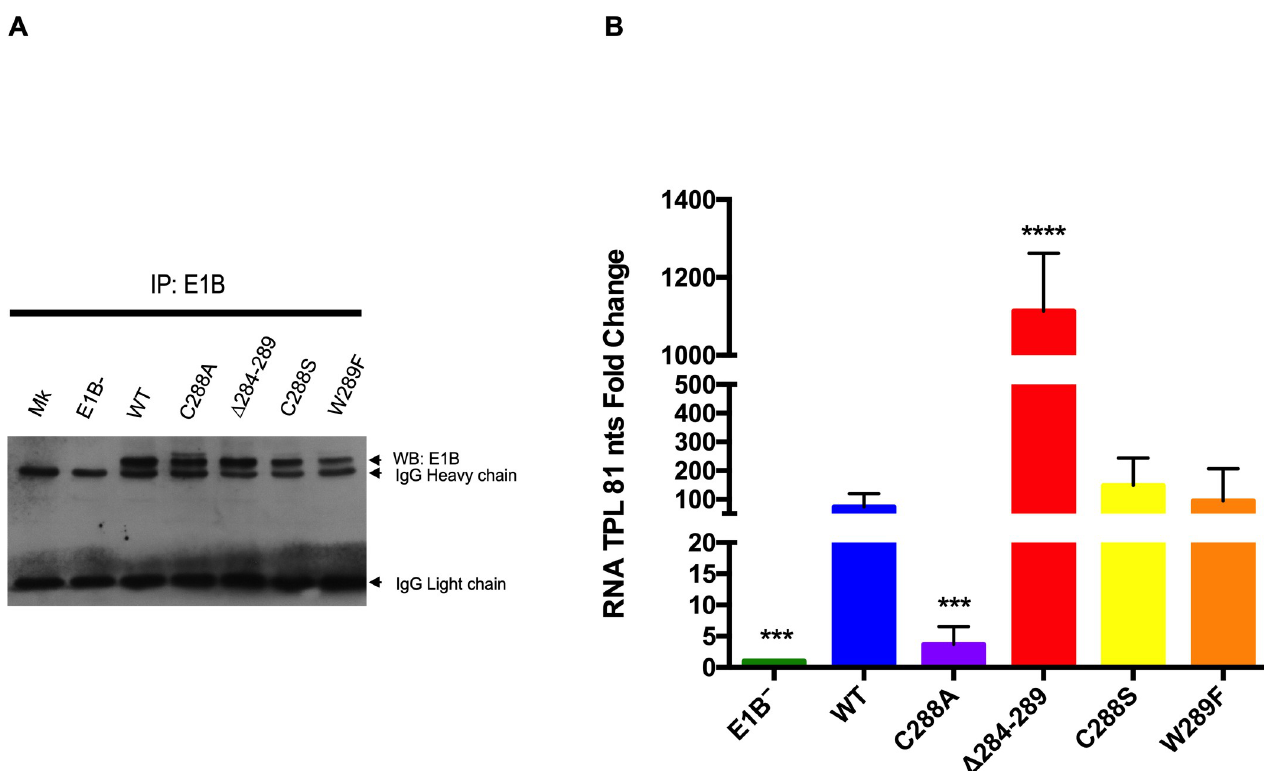
Fig 1. E1B 55K interacts with RNA in Ad5 WT-infected cells and RNP substitutions affect RNA binding. HFF cells infected with the indicated viruses were harvested at 36hpi. E1B 55K was immunoprecipitated with the 2A6 MAb, RNA was isolated and RT qPCR were performed to detect a sequence corresponding to intron 2 in the TPL. (A) Western blot of immunoprecipitated samples with the anti-E1B 55K 2A6 MAb. (B) RT qPCR of immunoprecipitated viral RNA. Immunoprecipitation data was normalized as described in Materials and Methods and it is represented as the percentage of the input RNA. Standard deviations from three independent experiments performed in triplicate are shown. ��� P < 0.001, ���� P < 0.0001.